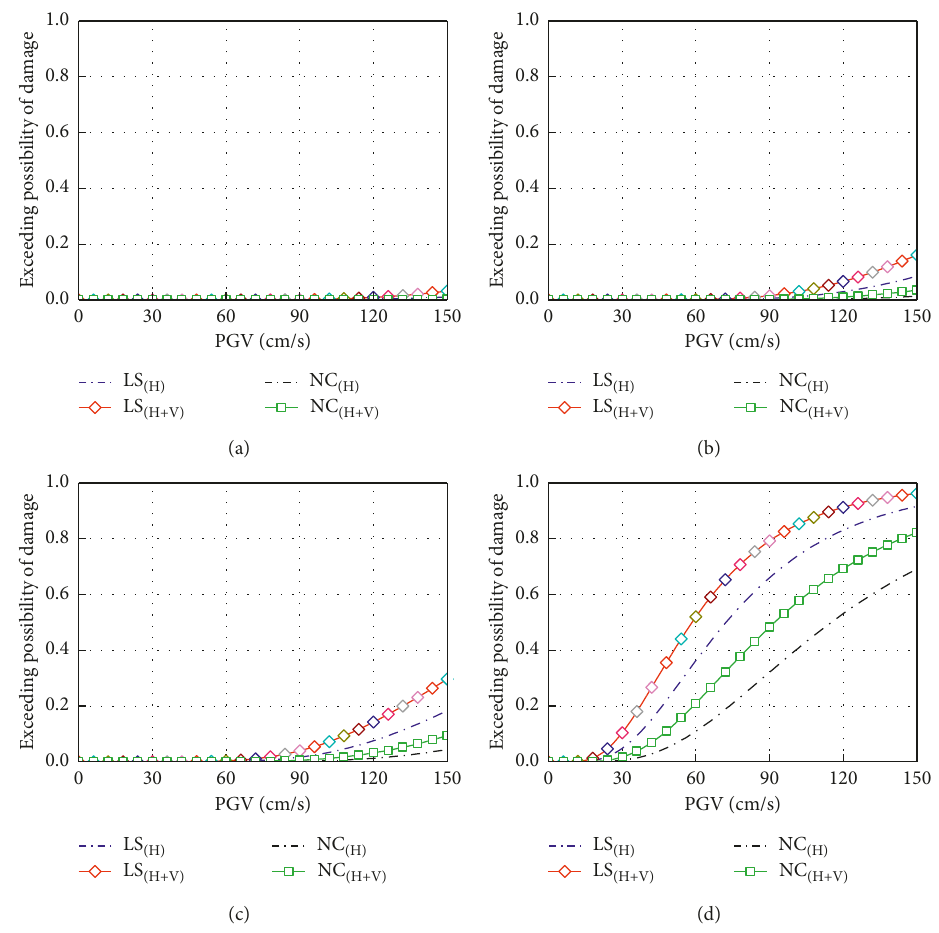
Figure 16: Comparison of fragility curves obtained from thresholds (H+V) and thresholds (H) . (a) Site I. (b) Site II. (c) Site III. (d) Site